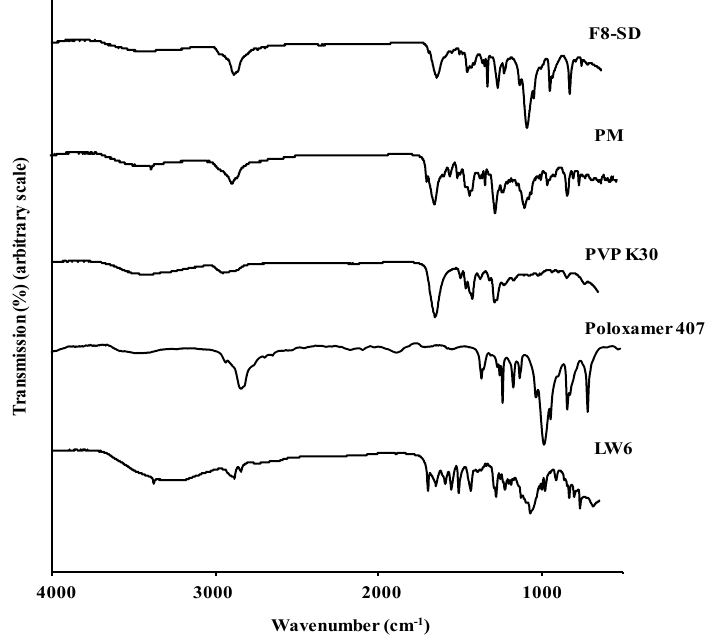
Figure 9. Fourier transform infrared (FT-IR) spectra of LW6, F8-SD, PM, and polymeric carriers.